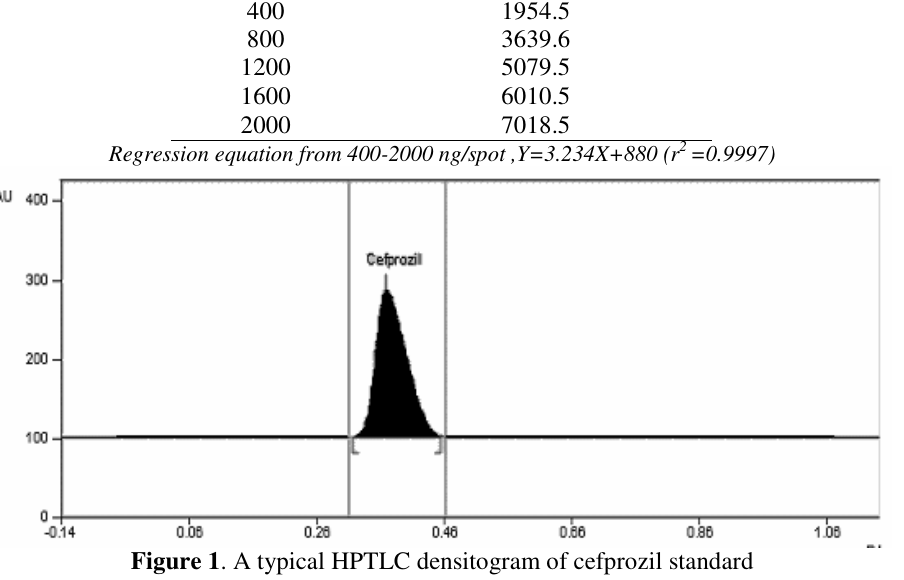
Figure 1 . A typical HPTLC densitogram of cefprozil standard